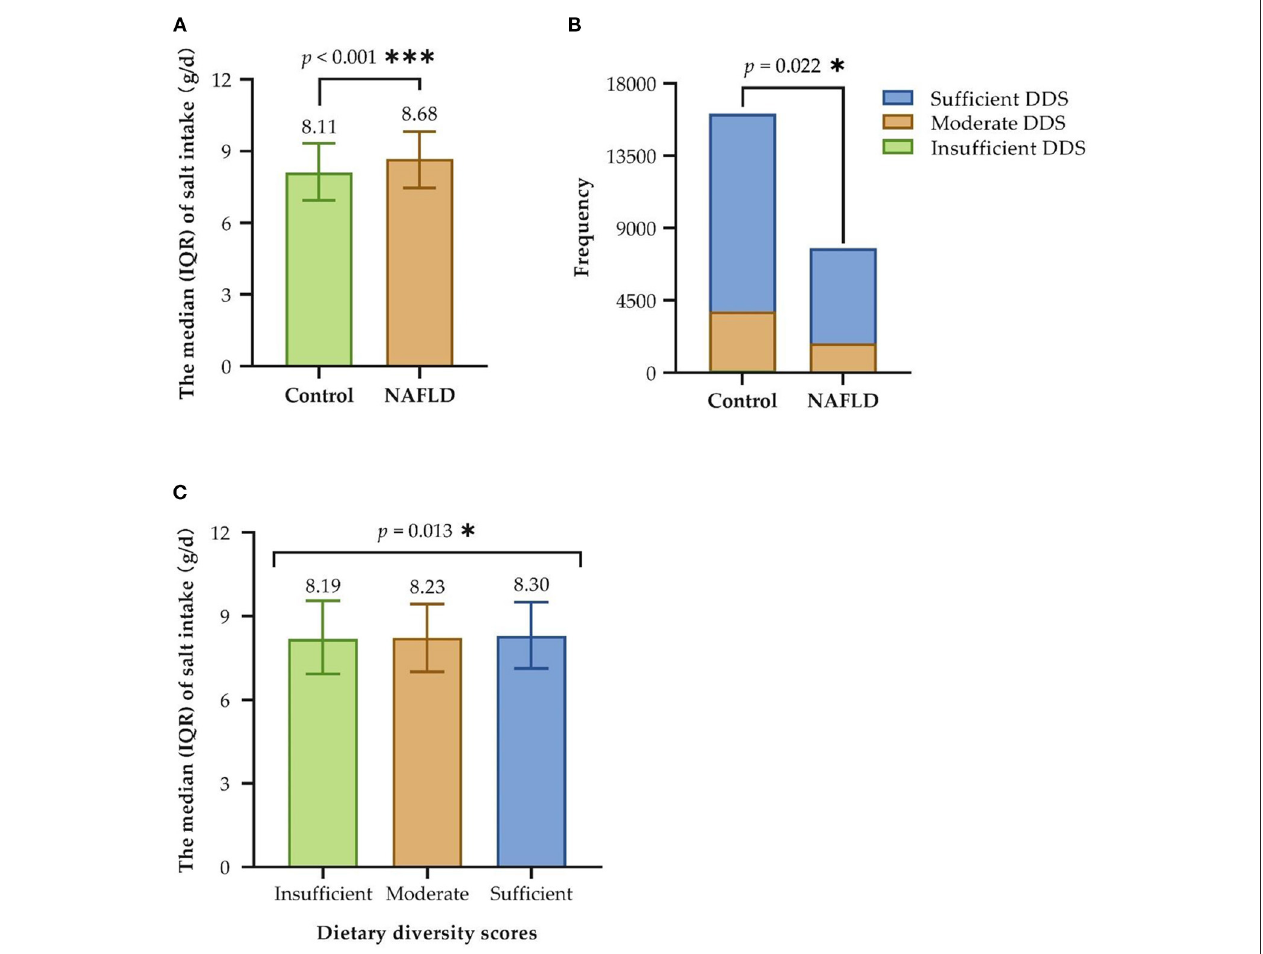
FIGURE 2 | Correlation between salt intake, dietary diversity, and NAFLD. (A) Univariate analysis of salt intake and NAFLD; (B) Univariate analysis of dietary diversity and NAFLD; (C) Univariate analysis of salt intake and dietary diversity. IQR, interquartile range; DDS, dietary diversity scores; NAFLD, non-alcoholic fatty liver disease; Insufficient refers to a score of 0–3, Moderate refers to a score of 4–6 and Sufficient refers to a score of 7–9; * P < 0.05; *** P <